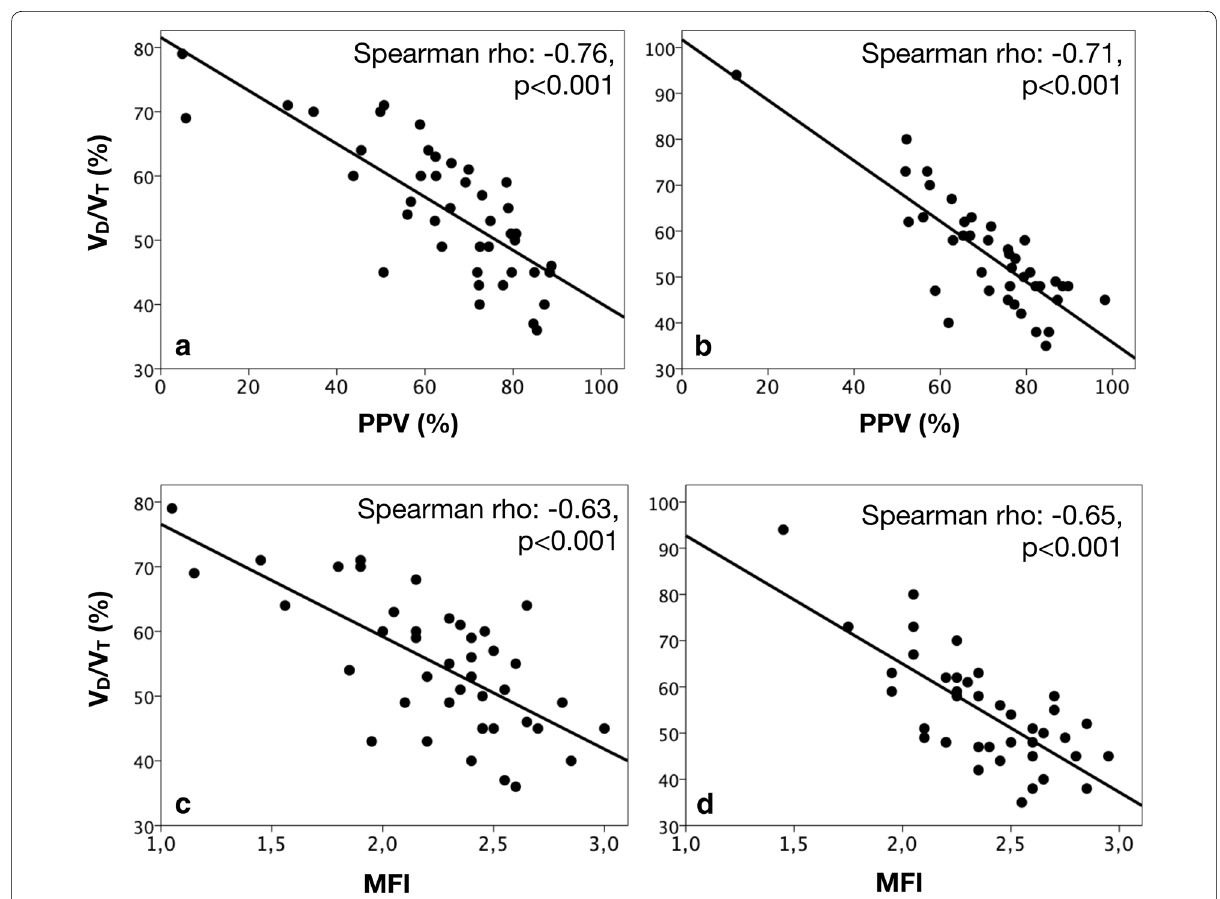
Fig. 1 Relationships between pulmonary dead‑space fraction ( V D / V T ) and the microcirculatory blood flow at baseline and 24 h after. a Scatter plot depicting the correlation between pulmonary dead‑space fraction ( V D / V T ) and the proportion of small vessels perfused at baseline. b Scatter plot depicting the correlation between pulmonary dead‑space fraction ( V D / V T ) and the proportion of small vessels perfused 24 h after. c Scatter plot depicting the correlation between pulmonary dead‑space fraction ( V D / V T ) and MFI at baseline. d Scatter plot depicting the correlation between pulmonary dead‑space fraction ( V D / V T ) and MFI 24 h after. PPV: percentage of small vessels perfused; V D /V T : pulmonary dead‑space fraction; HI: heterogeneity index of microcirculatory blood flow; MFI: microcirculatory blood flow